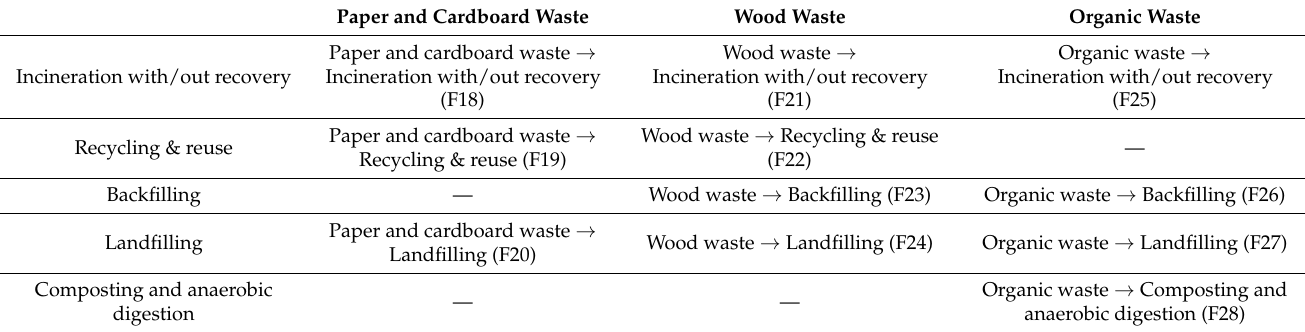
Table 3. LCW&R streams for secondary municipal and industrial wastes.